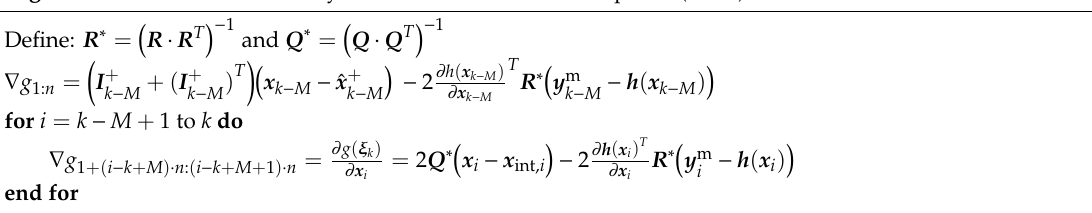
Algorithm 3. MHE calculation by means of functional mockup unit (FMU)